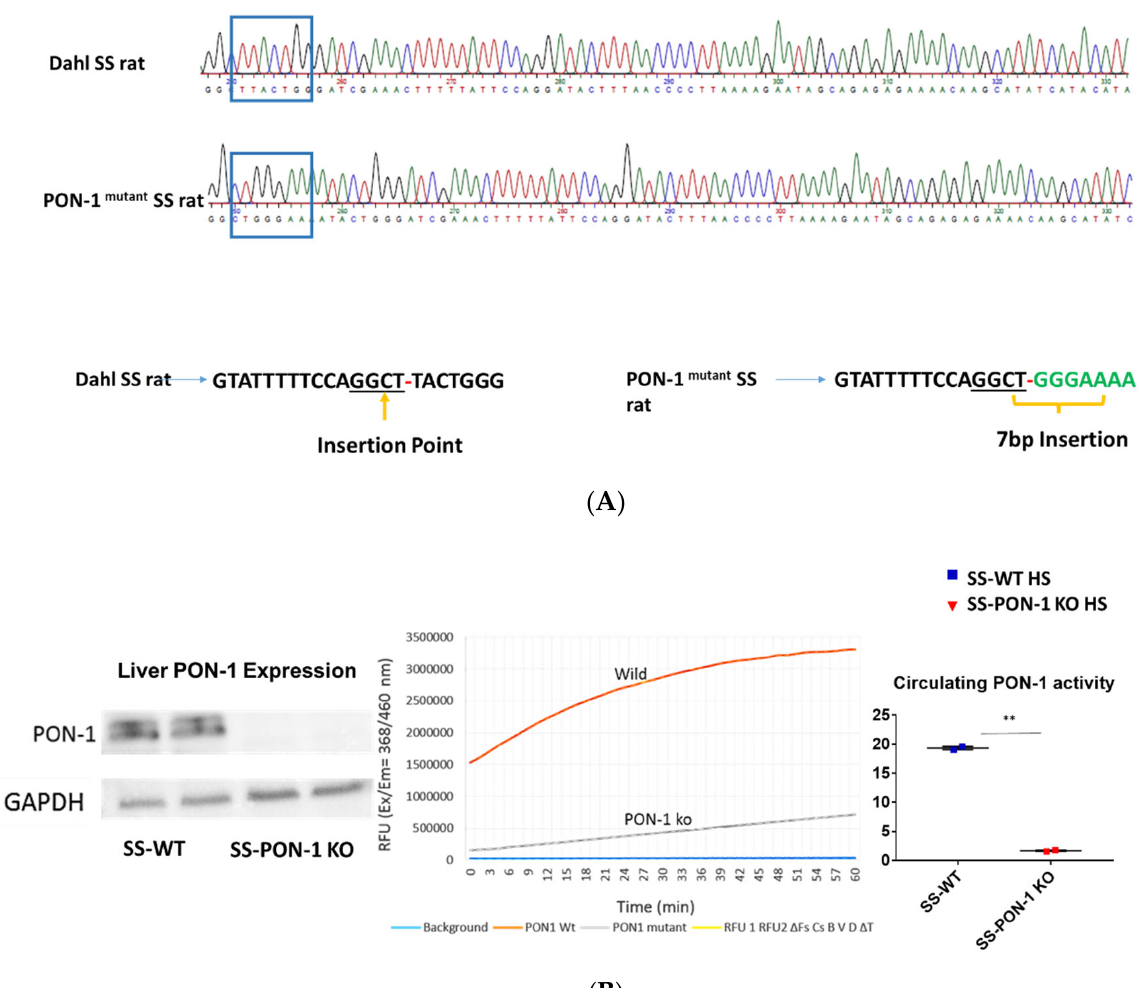
Figure 1. Screening animals for targeted mutation at the PON ‐ 1 locus. ( A ) Tail DNA samples were screened by Cel ‐ 1 assay and confirmed by Sanger sequencing. ( B ) Immunoblot analysis of PON ‐ 1 protein in liver from SS ‐ PON ‐ 1 KO mutant and SS rats (N = 2) and Circulating PON ‐ 1 activity assay analysis in plasma collected from SS ‐ PON ‐ 1 KO rats and SS rats (N = 2). Liver expression of PON ‐ 1 is abolished in SS ‐ PON ‐ 1 KO rats compared to SS ‐ wild rats PON ‐ 1 and leads to significantly decreased circulating PON ‐ 1 activity. ** p < 0.01 vs. high ‐ salt.